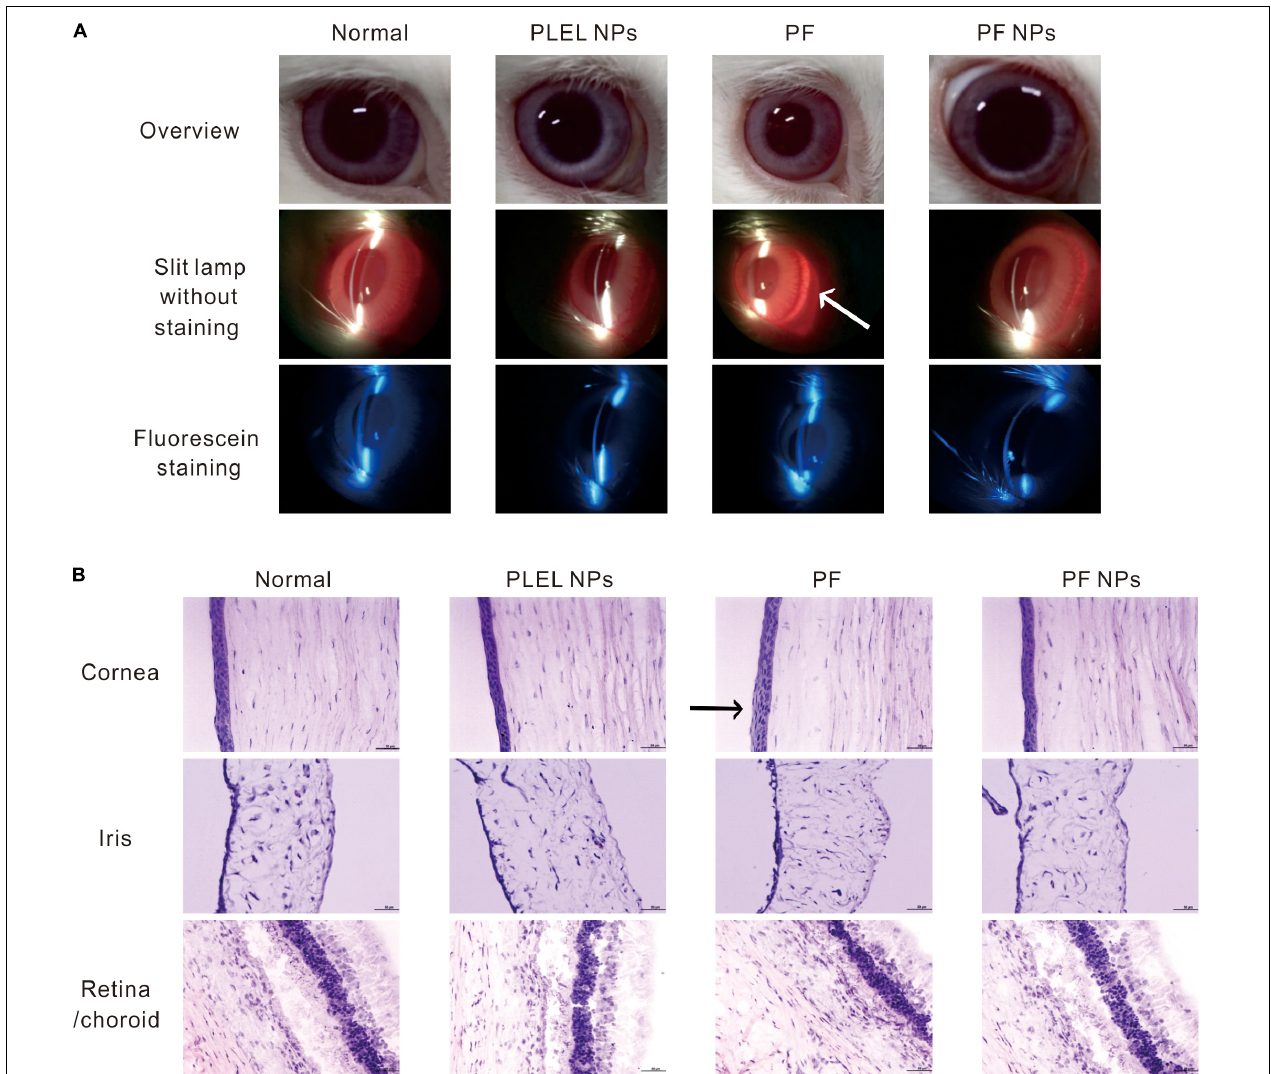
FIGURE 6 | Ophthalmic irritation studies. (A) Ocular observation. Arrow indicates mild redness of the eye (B) Histology analysis (HE staining). The rabbits’ eyes were treated with physiological saline (PS), PLEL NPs, PF, and PF NPs formulations for seven consecutive days. Scale bar, 50 µ m. Arrow indicates mild swelling in the corneal